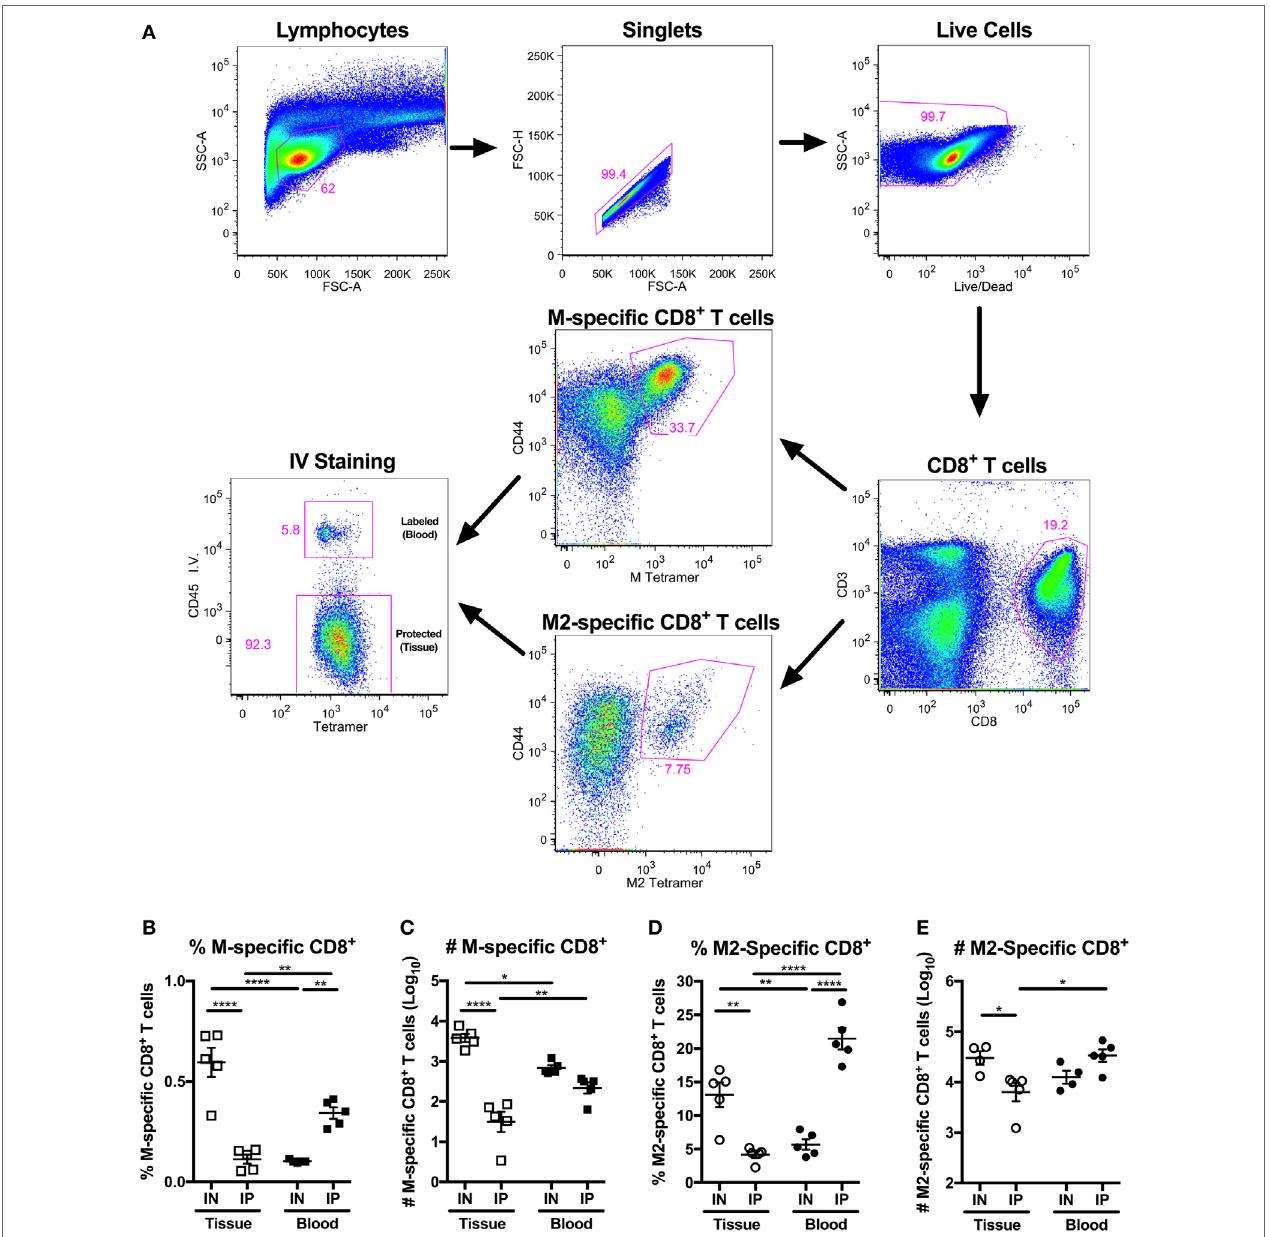
FigUre 1 | Intranasal (IN) vaccination with murine cytomegalovirus (MCMV)-M2 elicits more lung-resident M2-specific CD8 + T cells than intraperitoneal (IP) vaccination. (a–e) Mice were vaccinated with MCMV-M or MCMV-M2 via the IN or IP route. Intravascular staining was used in conjunction with D b /M 187–195 and K d /M2 82–90 tetramers to quantify epitope-specific CD8 + T cells in the lung tissue and blood after 1 week. (a) Gating strategy used to identify M-specific and M2-specific CD8 + T cells in the tissue and blood of the lungs. (B) Frequency and (c) number of M-specific CD8 + T cells in the tissue and blood of lungs 1 week after MCMV-M vaccination. (D) Frequency and (e) number of M2-specific CD8 + T cells in the tissue and blood of the lungs 1 week after MCMV-M2 vaccination. Bars indicate mean ± SEM ( n = 5 mice/group). **** P < 0.0001, ** P < 0.01, * P < 0.05 by two-way ANOVA. Data are shown from one experiment and representative of two independent experiments.